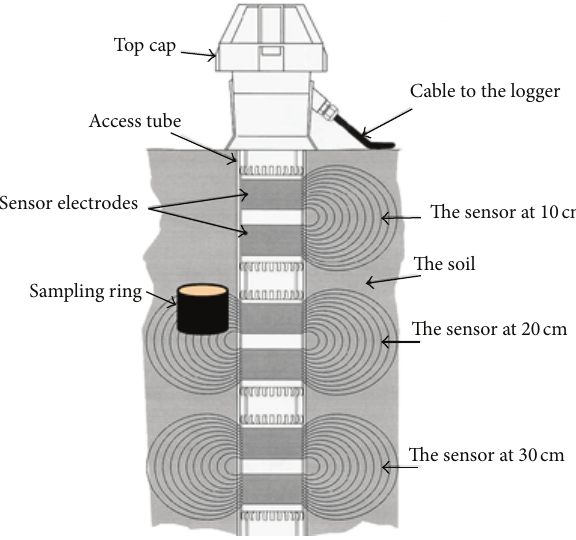
Figure 1: Calibration scheme of the capacitance